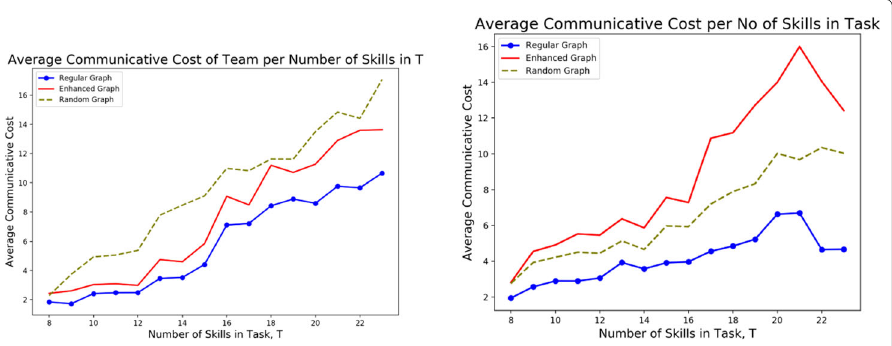
Fig. 12 Communicative Cost based on Machine Learning Probabilities. IBM (left) and Samsung